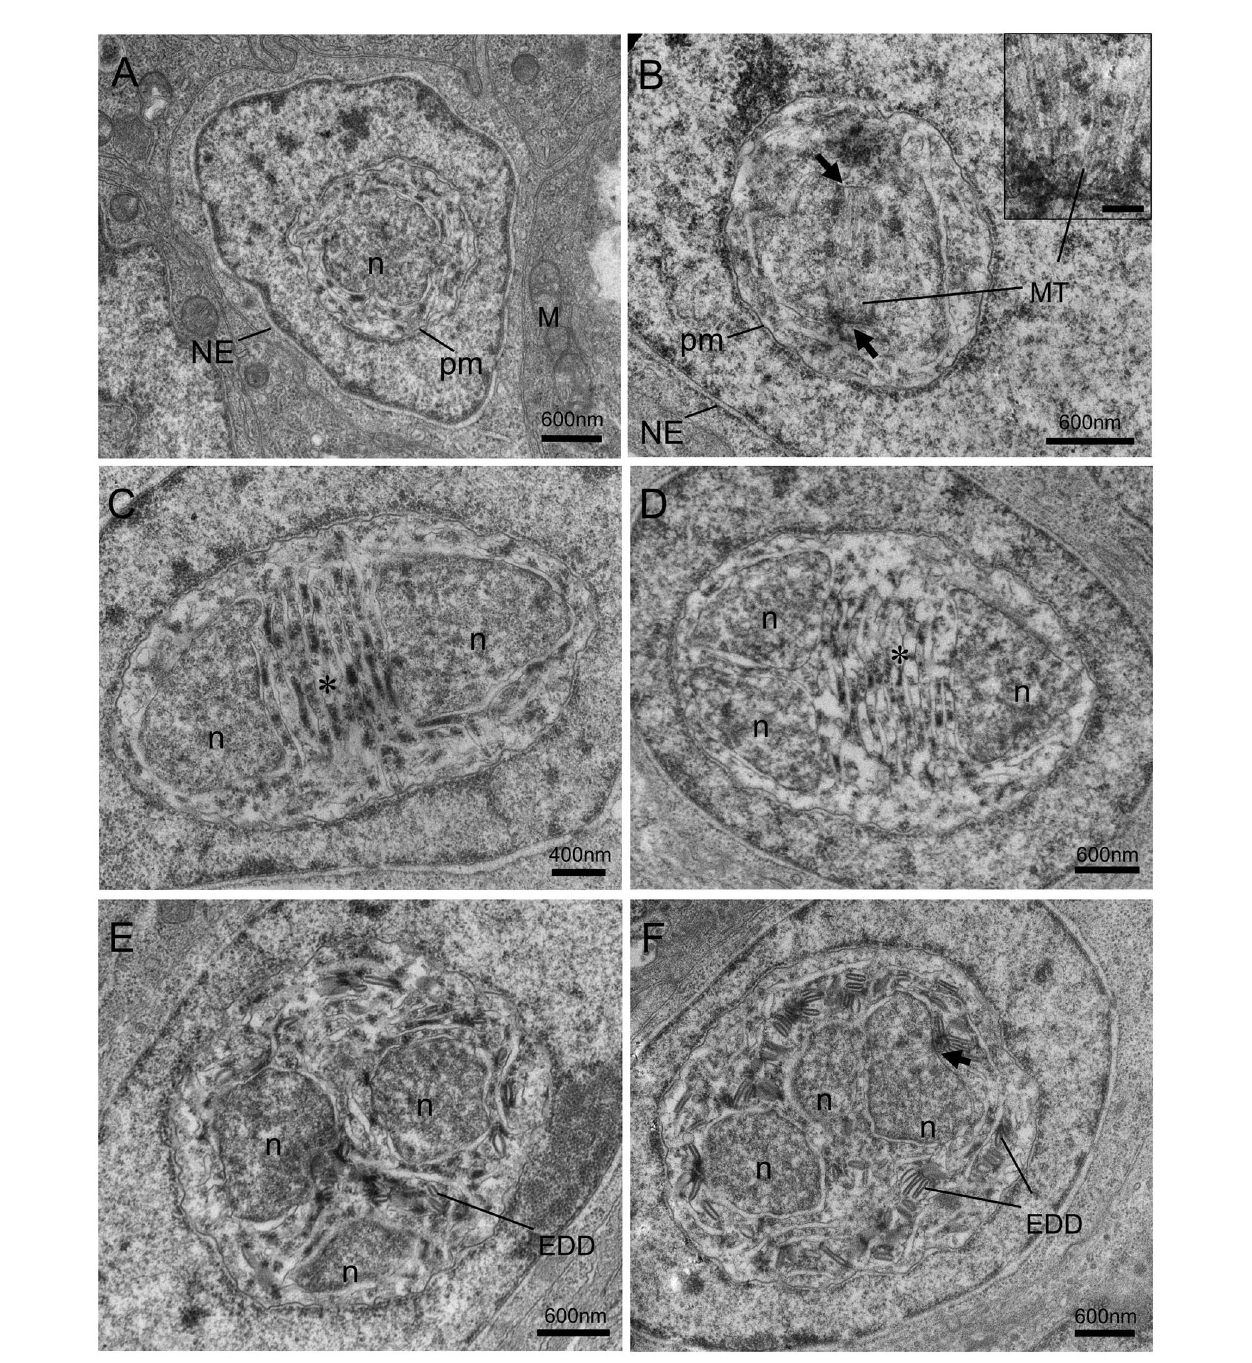
FIGURE 4 | Transmission electron micrographs of the merogonic and early sporogonic stages of Nucleospora hippocampi n. sp. in the nuclei of intestinal epithelial cells of the Hippocampus erectus . (A) Early uninucleate meront stage within the nucleoplasm of the host nucleus. Host nuclear envelope (NE), host mitochondria (M), the monokaryon (n), and plasma membrane (pm) of the meront. (B) The uninucleate meront undergoing karyokinesis. Long microtubules (MT) radiate from two spindle plaques (black arrows). Inset showing the details of the microtubules and spindle plaque. Insert scale bar = 0.1 m m. (C) The binucleate meront contains two nuclei (n) separated by claviform cytoplasm (asterisk). (D) The trinucleate meront with three nuclei and claviform cytoplasm (asterisk). (E) The electron-dense discs (EDD) appear in the cytoplasm of late trinucleate meront (or early sporogonial plasmodium). (F) An early sporogonial plasmodium with increasing EDD around three nuclei. The spindle plaque (black arrow) forming on one nucleus indicates nucleus division